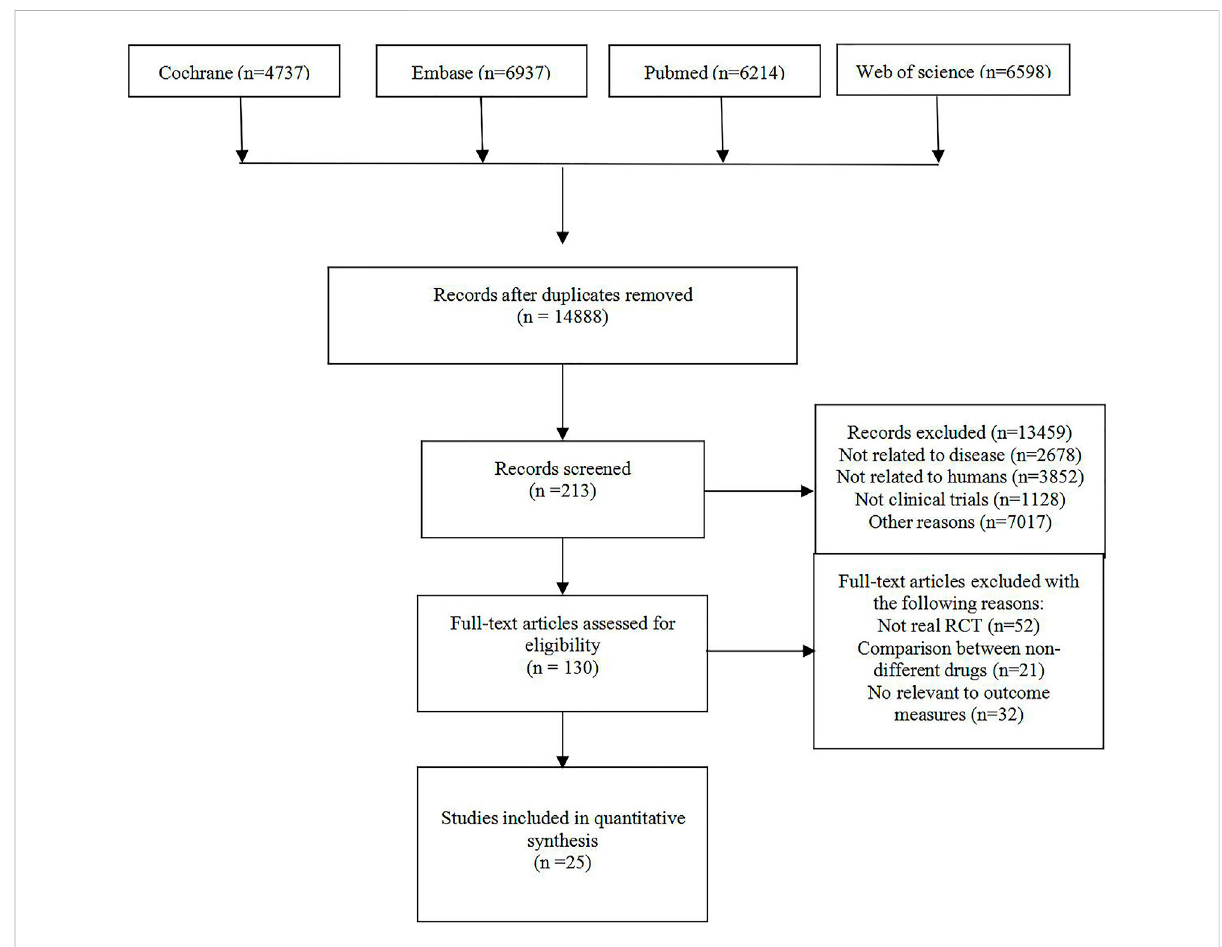
FIGURE 1 Review pro fi le. RCT = randomized controlled